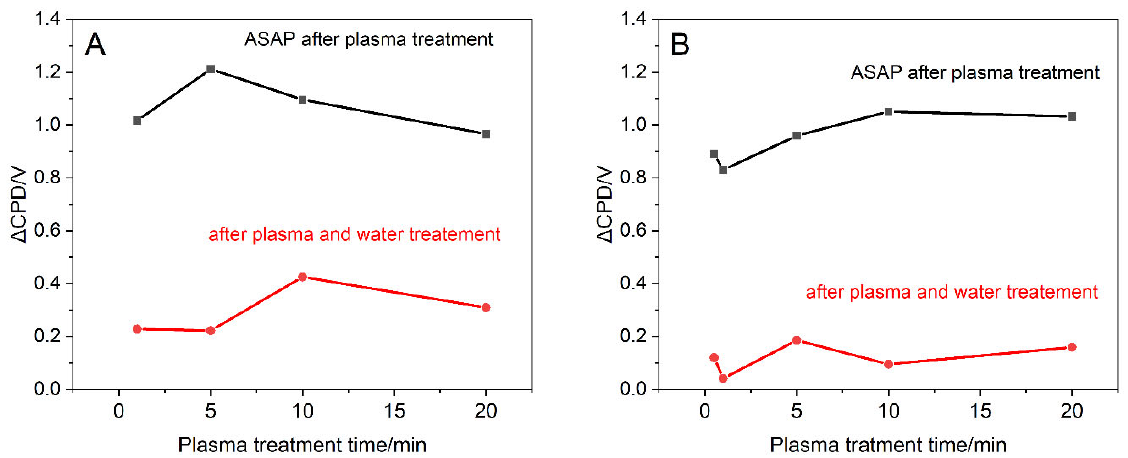
Figure 3. Changes in graphite surface contact potential difference (work function) for different times of plasma treatment with O 2 ( A ) and CO 2 ( B ). ASAP–CPD measurement performed as soon as possible after plasma treatment.